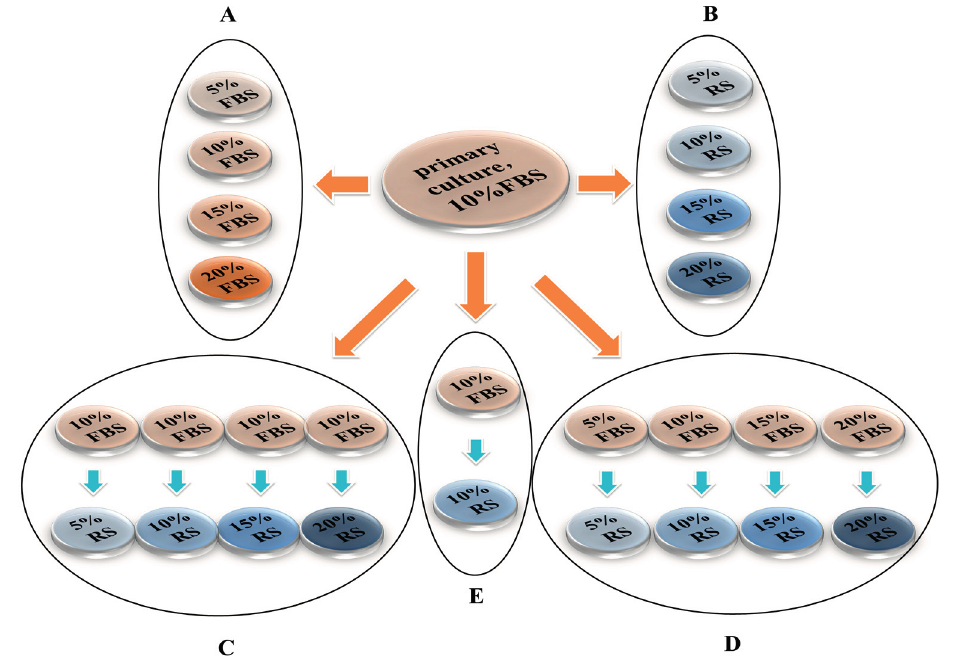
Figure 10. Illustration of the experimental groups in this study. Eight kinds of medium contained 5%, 10%, 15% or 20% FBS or RS. OEC were first cultured in 10% FBS to complete the primary culture. The OEC subculture was divided into 5 treatment groups as follows: ( A ) after trypsinization, OEC were placed onto slides and cultured in different concentrations (5%, 10%, 15%, 20%) of FBS for 7 days; ( B ) after trypsinization, OEC were cultured in different concentrations (5%, 10%, 15%, 20%) of RS for 7 days; ( C ) after trypsinization, OEC were cultured in 10% FBS for 3 days and then cultured in four different concentrations (5%, 10%, 15%, 20%) of RS for another 4 days; ( D ) after trypsinization, OEC were placed onto slides, cultured in four different concentrations (5%, 10%, 15%, 20%) of FBS for 3 days, and then cultured in RS (concentrations: 5%, 10%, 15%, 20%) for another 4 days; and ( E ) the OEC were first cultured in 10% FBS for 3 days and then cultured with rat spinal cord explants with 10% RS for another 4 days. The orange arrows indicate that trypsin was applied, and the blue arrows indicate that trypsin was not